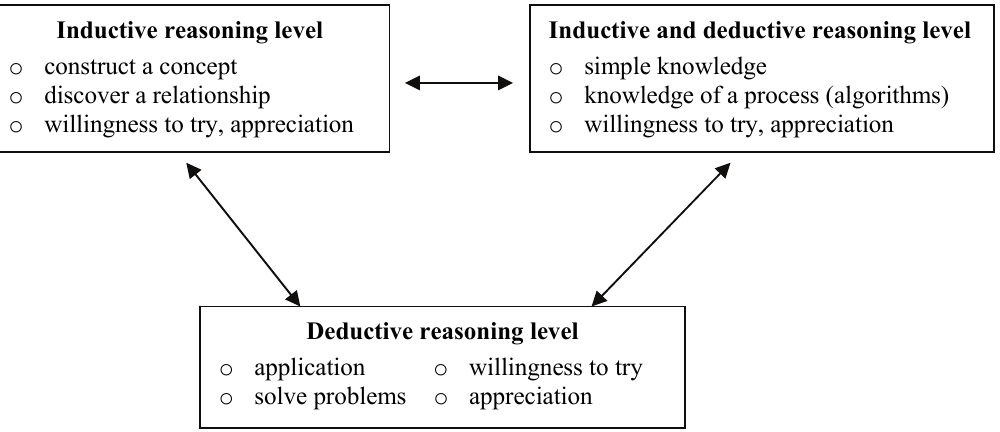
Figure 1 : A guided problem solving teaching